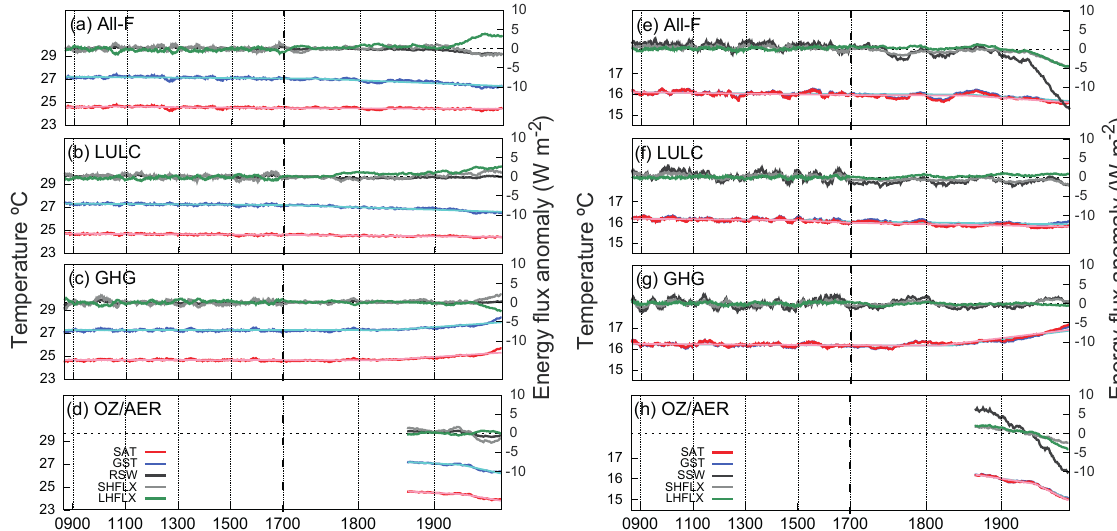
Figure 14. The same as in Fig. 11 but for two different regions: northeast Brazil between 1–11 ◦ S and 47–35 ◦ W (a) and southeast China between 22–32 ◦ N and 103–122 ◦ E (b) . For northeast Brazil RSW is represented whereas for southeast China SSW is shown instead. LHFLX and SHFLX are shown in both cases.